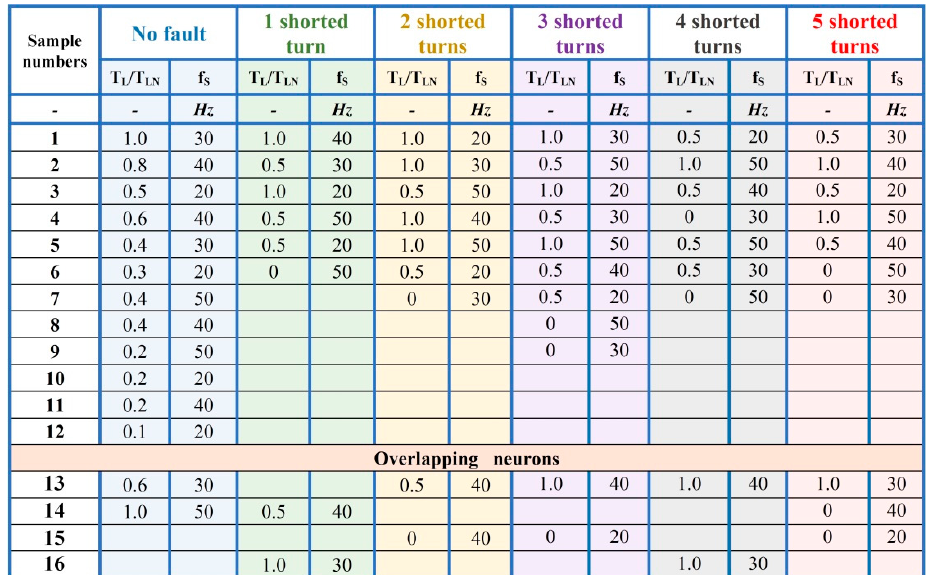
( b ) Figure 13. Classification of the induction motor failures: ( a ) stator windings faults: dotted lines—IM damage categories involved in the classification, hatched areas—IM damage categories not involved in the classification; ( b ) mixed faults: dotted lines—IM damage categories not involved in the classification; 10 × 10 SOM; N sh —number of shorted turns in the stator winding, N bb —number of broken rotor bars. The responses of the Kohonen network to the testing patterns, shown in Figure 13a in the case of ITSC faults, provide information about both the type of damage and the degradation scale of the